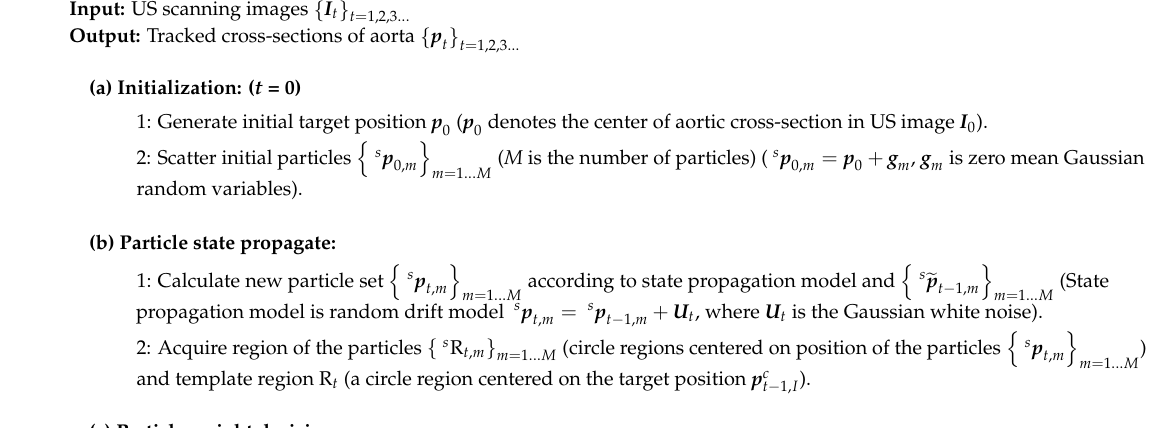
Algorithm 1: Multi-feature particle filter for tracking of aortic cross-section in real-time US (ultrasound) images Input: US scanning images { I t } t = 1,2,3...